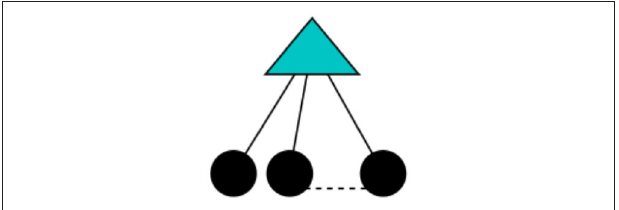
FIGURE 7 | Usage degree of objects of Basov (2018). Black circles, actors; Cyan triangles, objects; Gray lines, usages of objects.